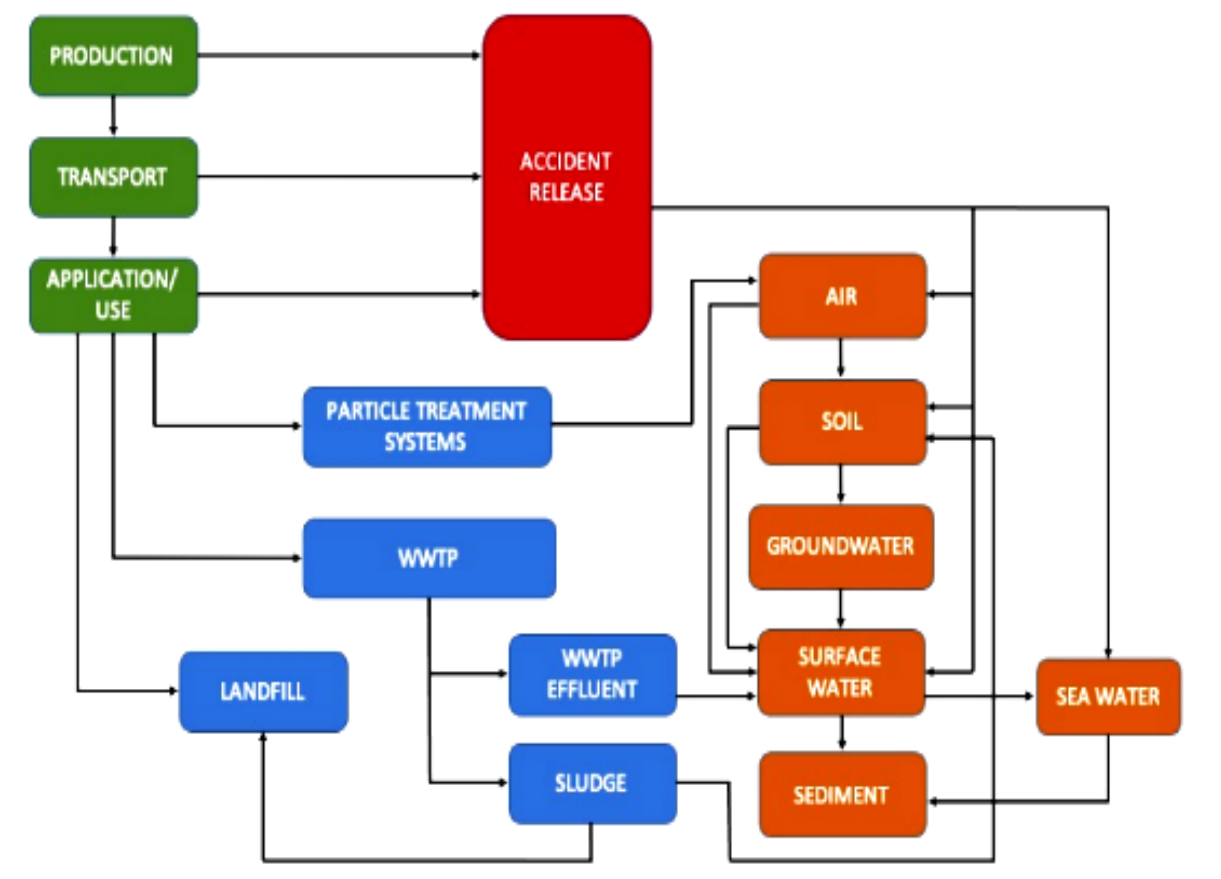
Figure 2. AgNPs’ release pathways and associated impacts on the environment (reprinted with permission from [14]).